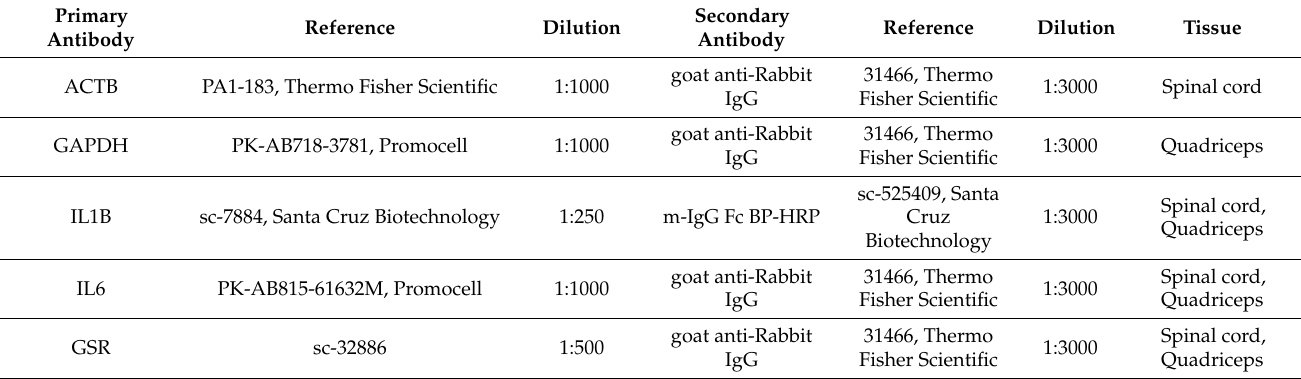
Table 3. List of primary and secondary antibodies used in western